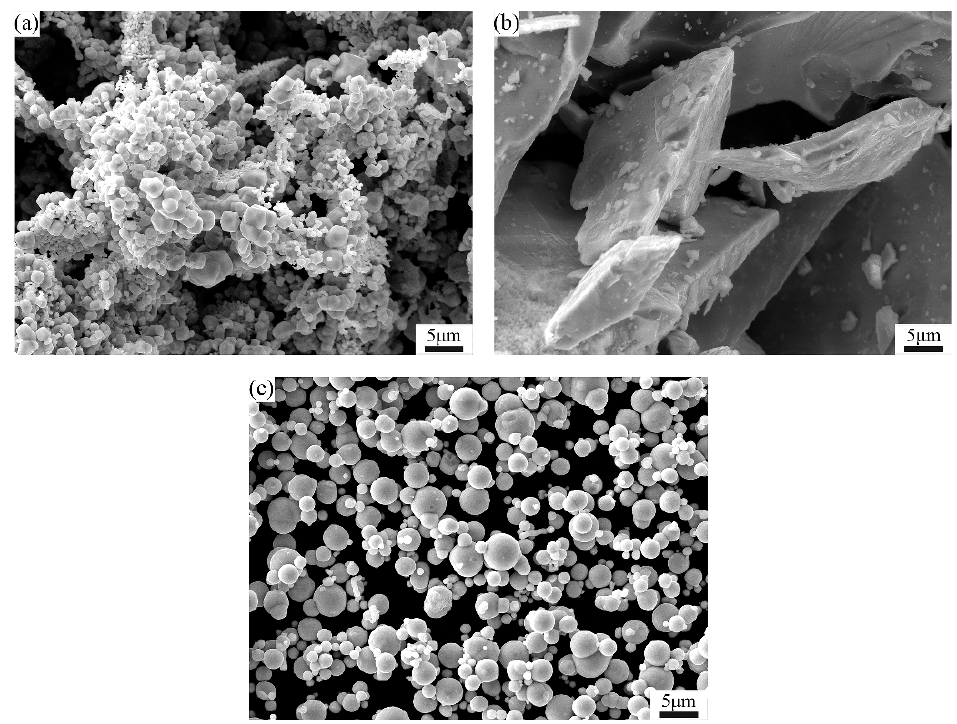
Figure 1. SEM micrographs of raw materials: ( a ) Mo; ( b ) FeB; ( c ) carbonyl Fe.